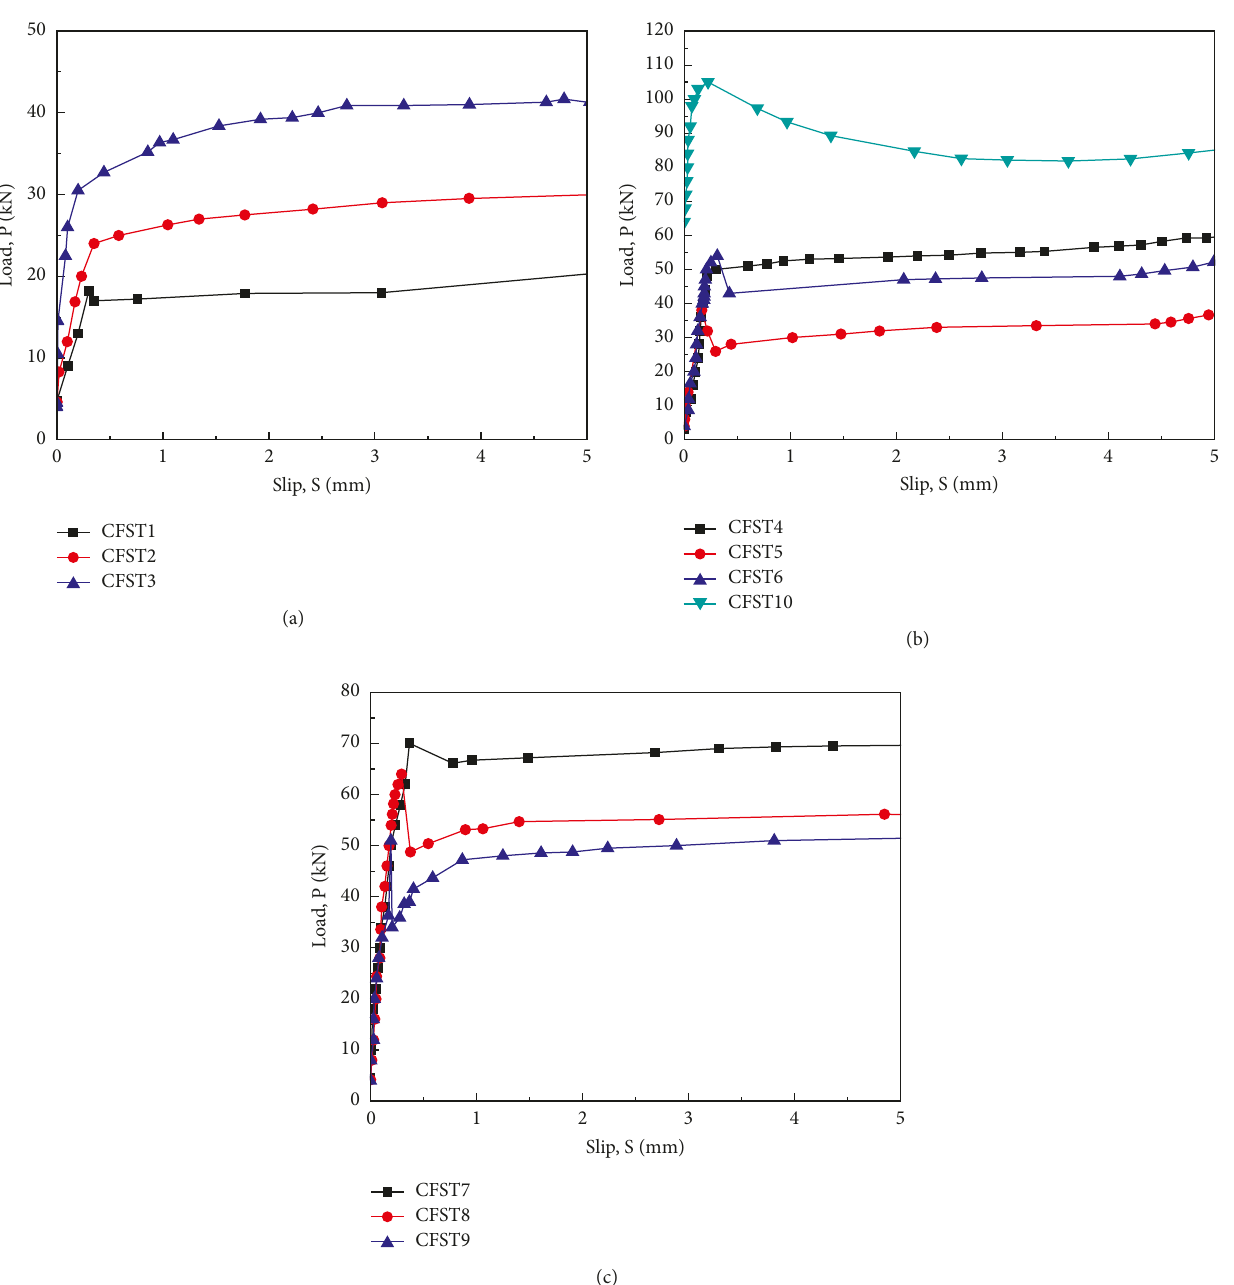
Figure 8: P-S curves of the free